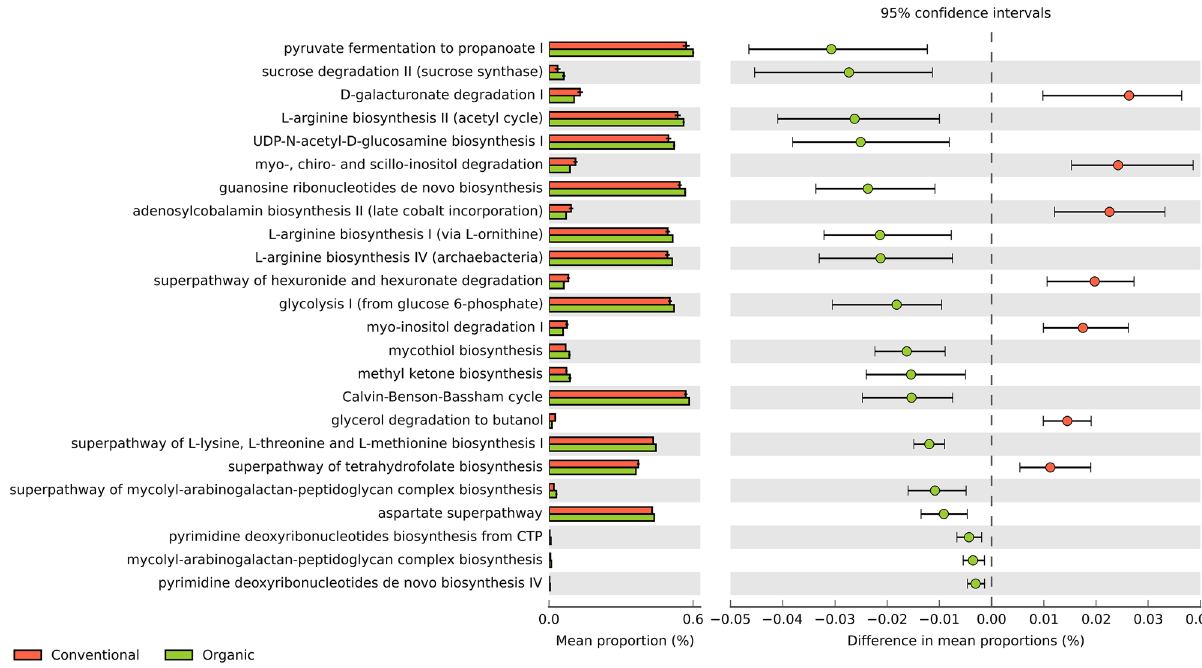
Figure 10. Metabolic pathways of prokaryotes, differentially enriched in the sugarcane rhizosphere in the organic versus conventional farming system. The White’s t-test was used for significance evaluation, considering a p -value ≤ 0.05 as statistically significant. The pathways in red represent the conventional system and in green, the organic one.